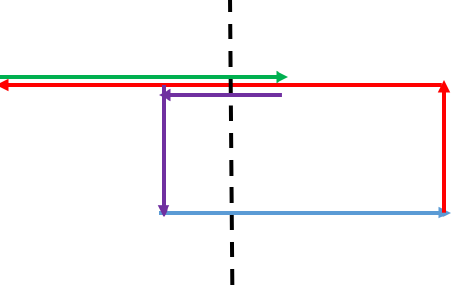
GT Figure 4: Acting G − 1 T on an SO ( 3 ) monopole. The first T action is marked in 1 1 1 blue, the following G action is marked in red, the next T action is marked in green, 1 and the last G − 1 action is marked in purple. The dashed line is the reflection axis of G . This figure shows that the operation G − 1 T GT moves an SO (( 3 ) monopole along 1 1 a trajectory that encloses a fundamental